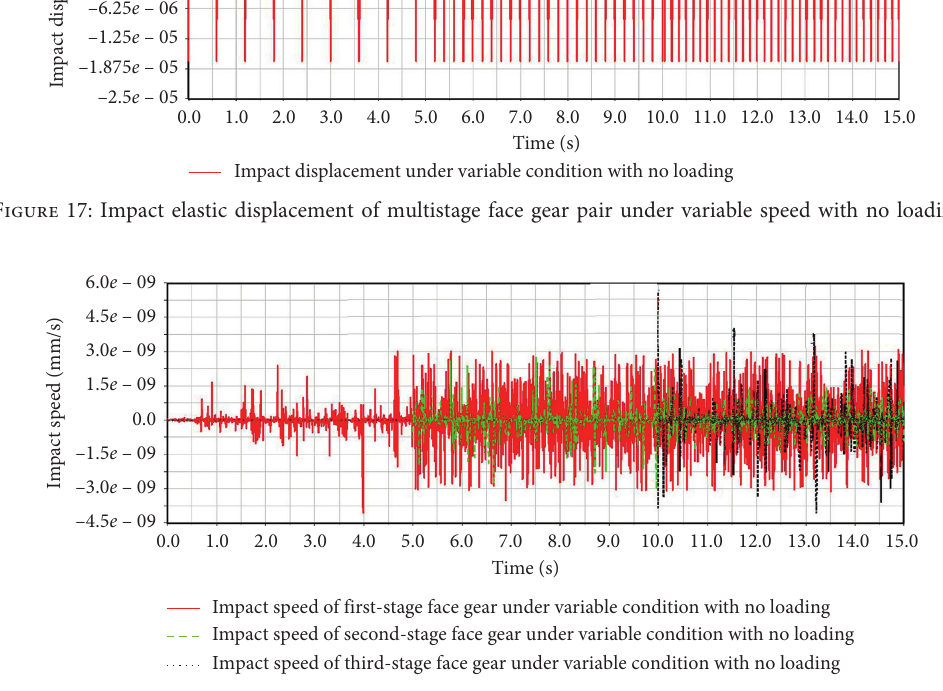
Figure 18: Impact speed of multistage face gears pair under variable speed with no loading.